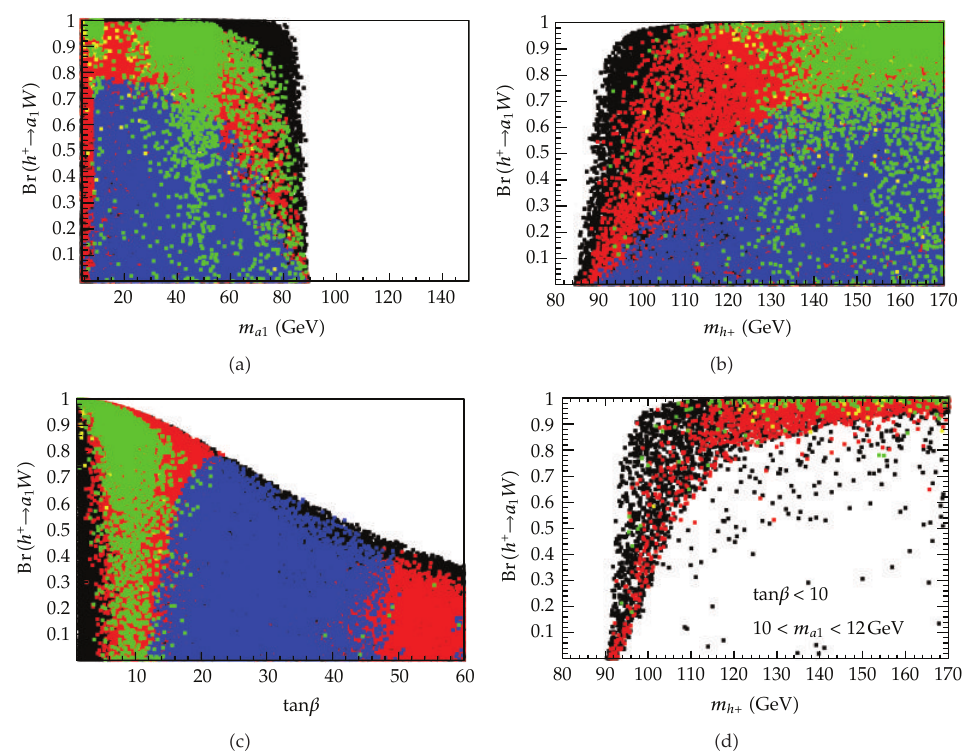
Figure 2: The branching ratio for h ± → a 1 W when scanning over the parameters in the scenario under consideration (cid:2) see text for details (cid:3) with the various constraints applied. The colour coding is the same as in Figure